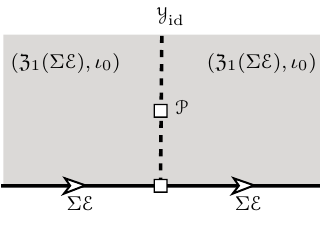
Figure 6 . A 1d SPT P is realized as an invertible domain wall on the trivial 2d SPT Y id